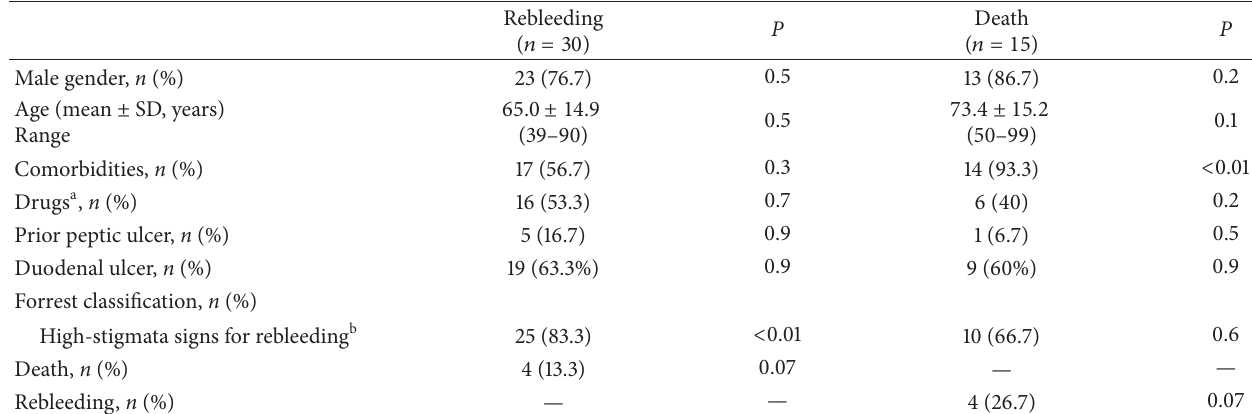
Table 3: Outcomes of patients with bleeding